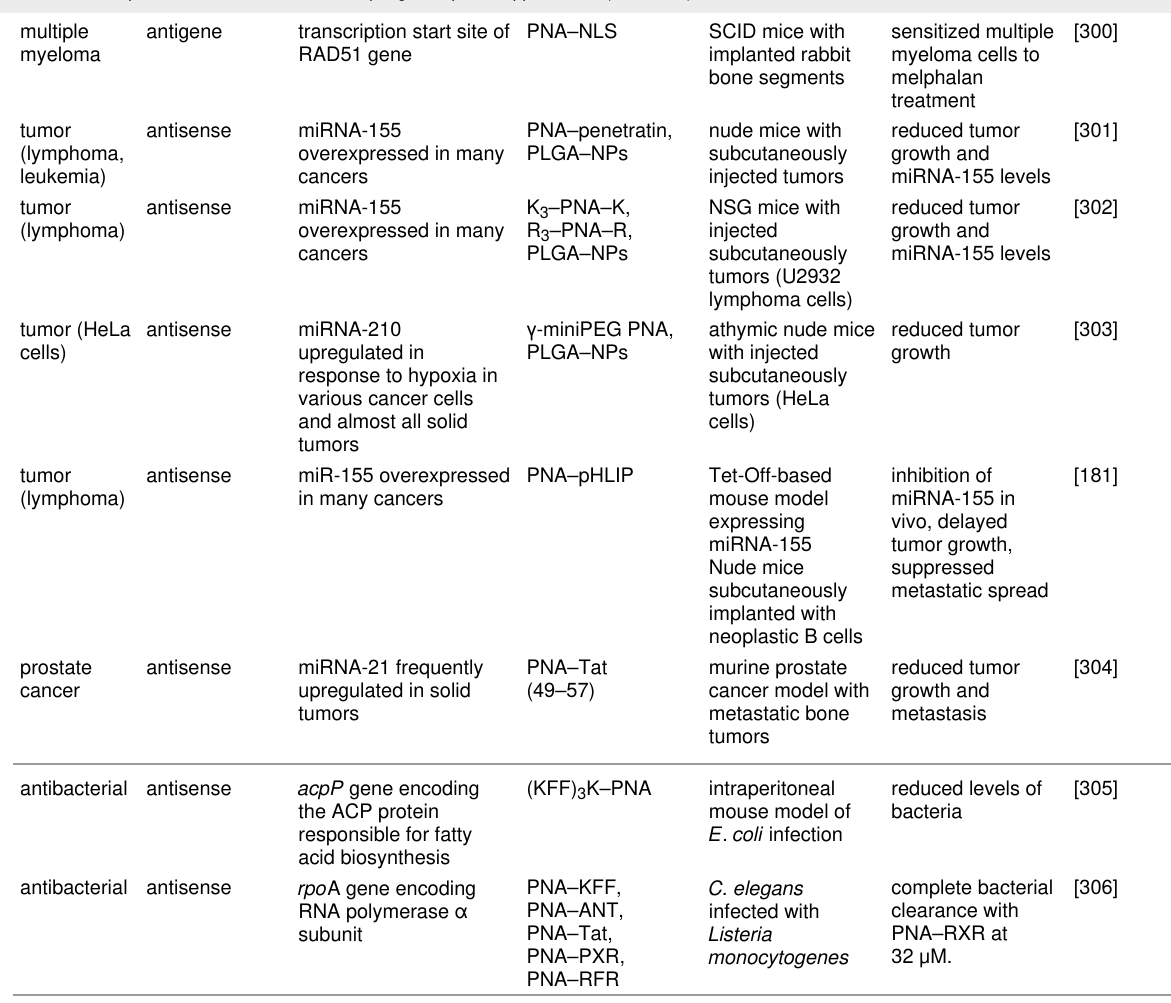
Table 1: Examples of advanced studies attempting therapeutic applications. (continued) multiple